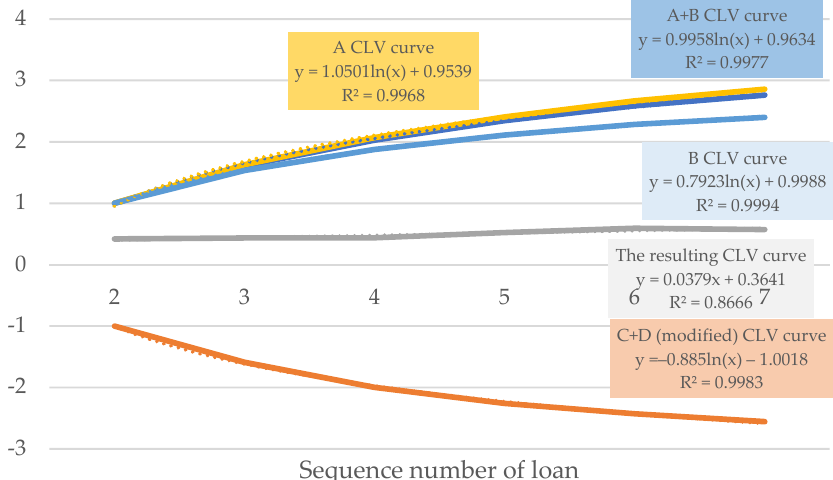
Figure 6. Graphs of CLV for segments A, B, A+B, C+D and resulting CLV.